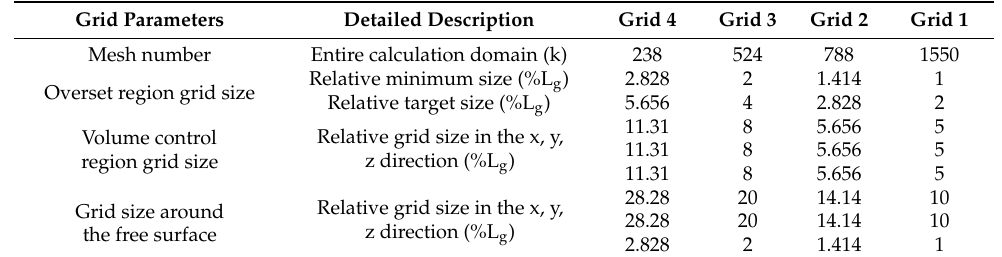
Table 3. Parameters of the four grids.